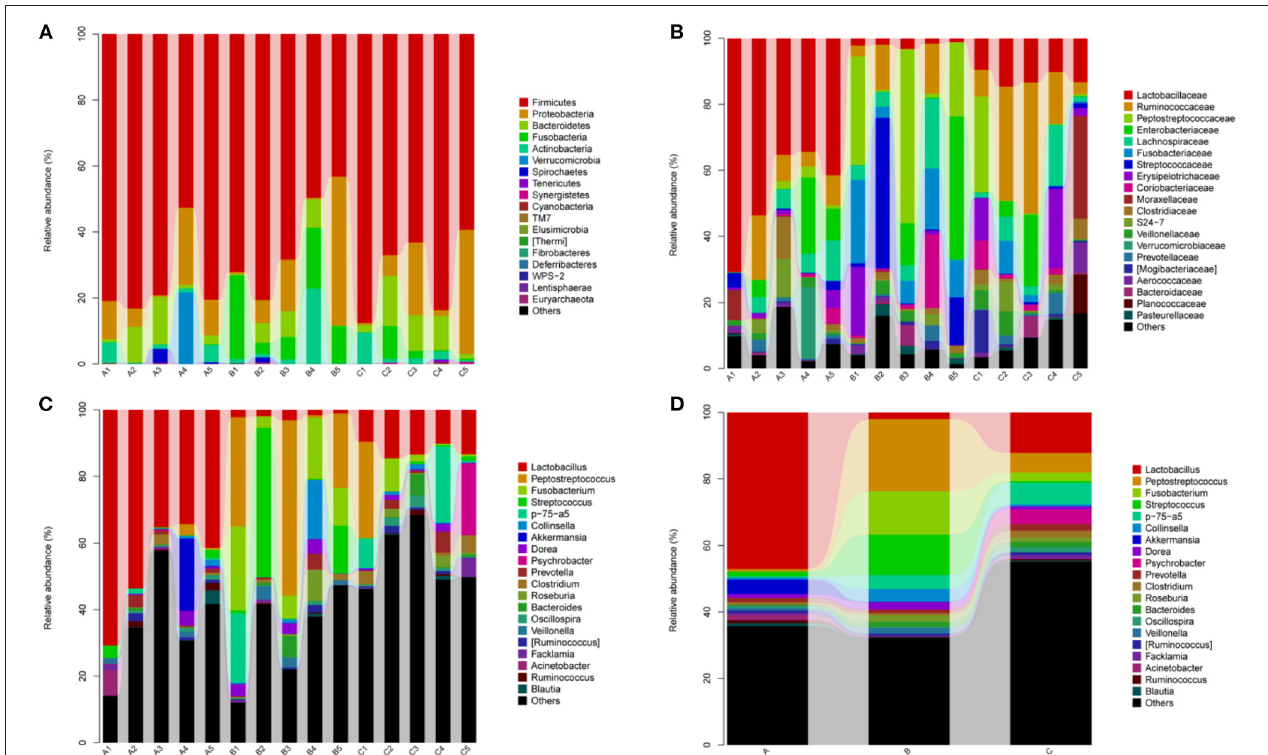
FIGURE 4 | Relative abundance of gut bacterial taxa among different groups. (A) Phylum level; (B) Family level; (C) Genus level; (D) Taxonomic assignment at genus level. A1–A5: Healthy piglets; B1–B5: Diarrheal piglets; C1–C5: Treatment